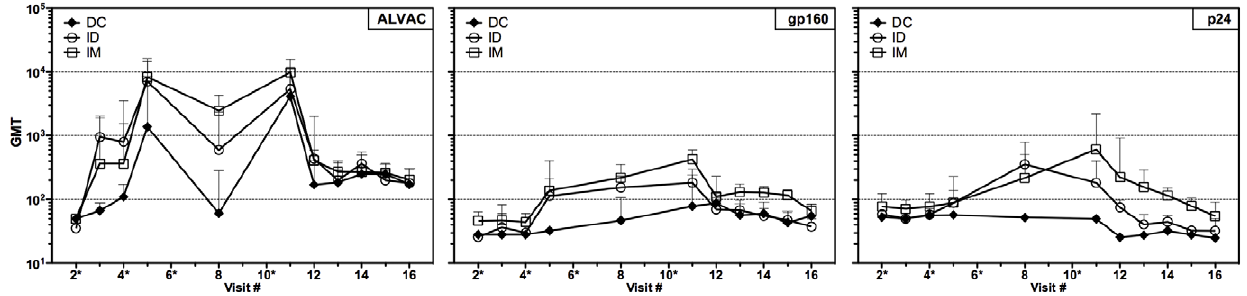
Figure 3. Antibodies develop after vaccination. Humoral responses to the vaccine vector (ALVAC, left panel) and insert genes HIV-gp160 (middle panel) and HIV-p24 (right panel). Data points are the geometric mean titers (GMT) + SEM bars for all subjects within each study arm receiving vaccine. Visit numbers are indicated and an asterisk (*) denotes vaccination visits. Closed diamonds, autologous DC route; open circles, ID route; open squares, IM route.